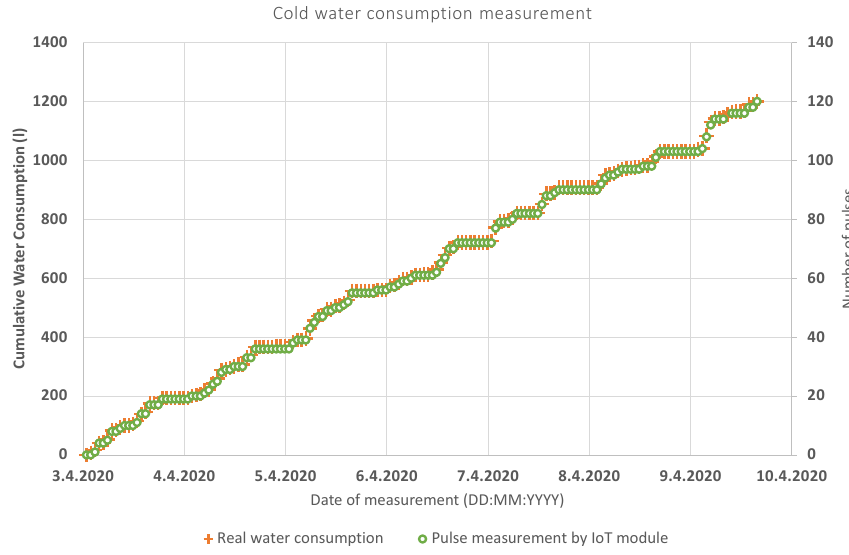
Figure 15. Comparison between remote and manual reading—cold